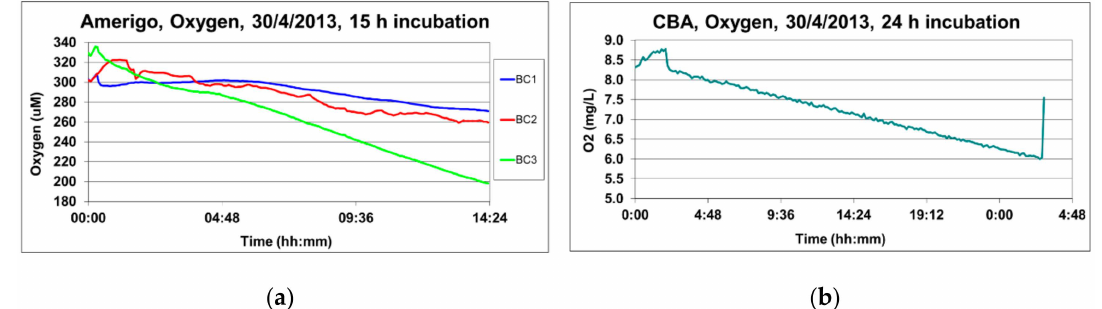
Figure 16. ( a ) Oxygen values recorded in the three benthic chambers of the Amerigo Lander (BC1, BC2, BC3) during deployment; ( b ) oxygen values recorded in the CBA during deployment of the two devices at the same time and site, a mud bottom sediment rich in fresh organic matter (Po River Prodelta).